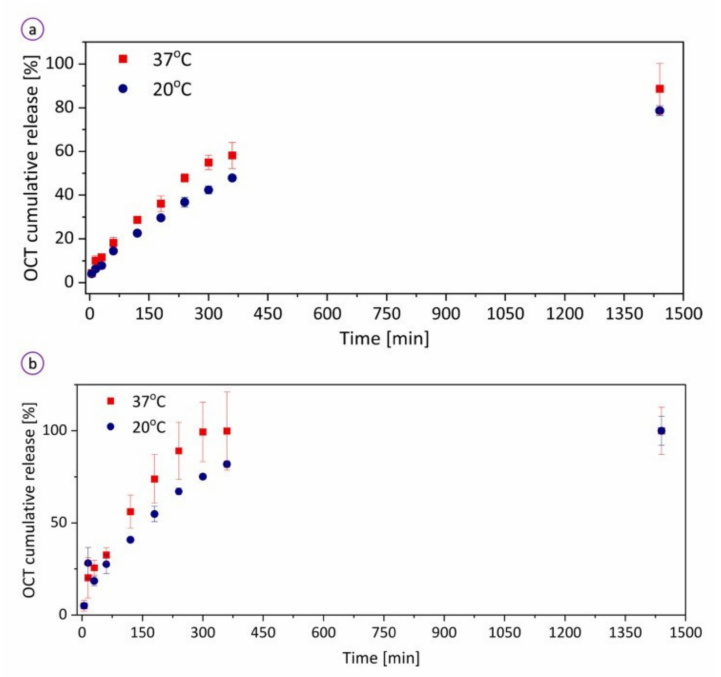
Figure 7. At temperatures of 20 and 37 ◦ C, OCT release profiles from the hydrogel to ( a ) water and